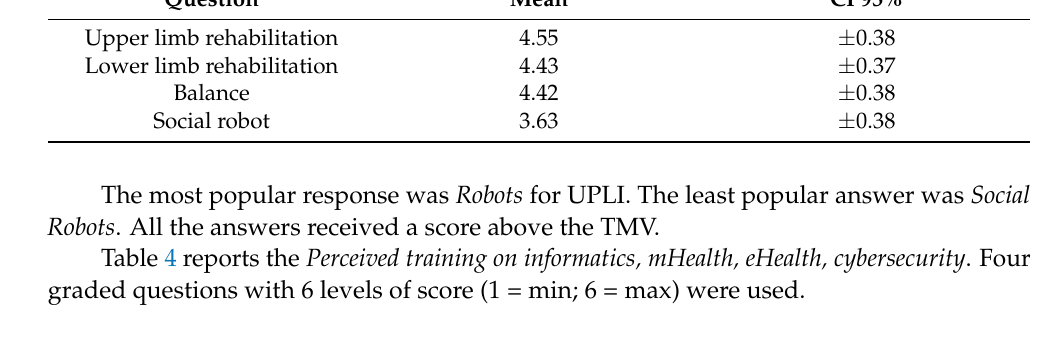
Table 4. Perceived degree of training on informatics, mHealth, eHealth, cybersecurity. Question Mean CI 95% Informatics